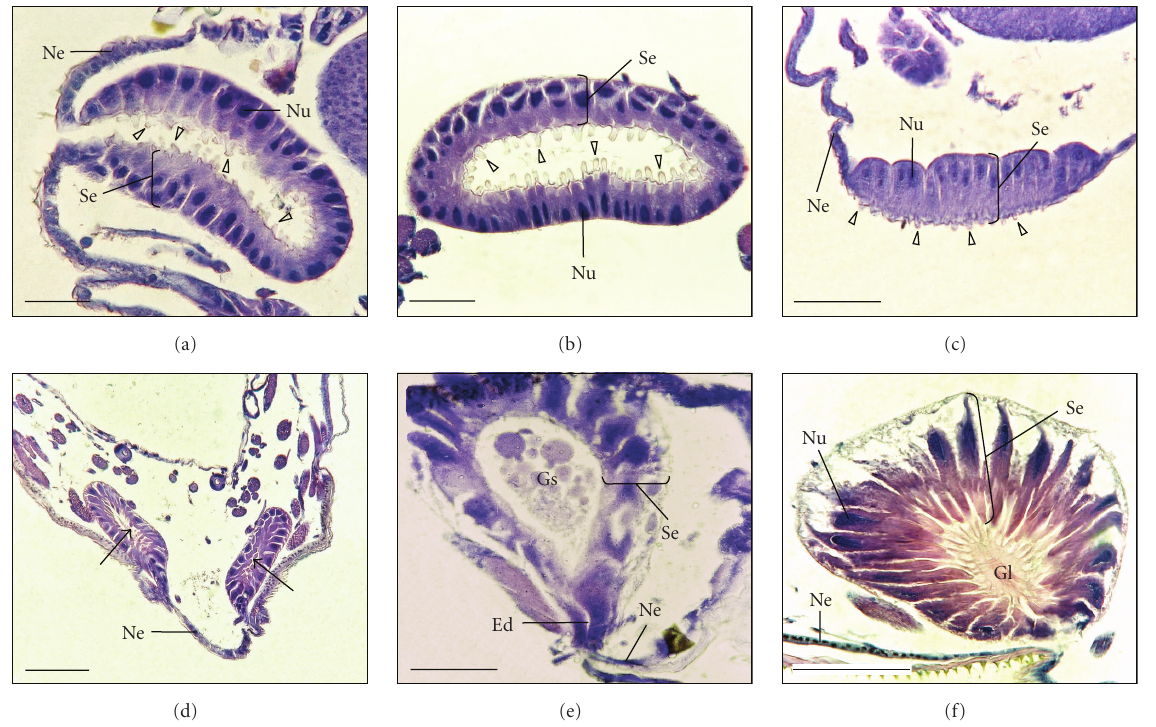
Figure 3: Histological sections of larval prosternal glands of Heliconius erato phyllis under light microscopy. (a) impair gland of second instar, longitudinal; (b) impair gland of third instar, cross section; (c) impair gland of first instar, longitudinal; (d) paired glands (arrows) of third instar, longitudinal; (e) paired gland of fourth instar, longitudinal, near the external opening, showing secretion in the lumen; (f) paired gland of fifth instar, cross section, at the middle of the secretory portion, showing the convergent distribution of secreting cells in relation to the lumen. Open arrowheads indicate the excretory cisterns in the impair gland. Ed: excretory duct; Gl: glandular lumen; Gs: